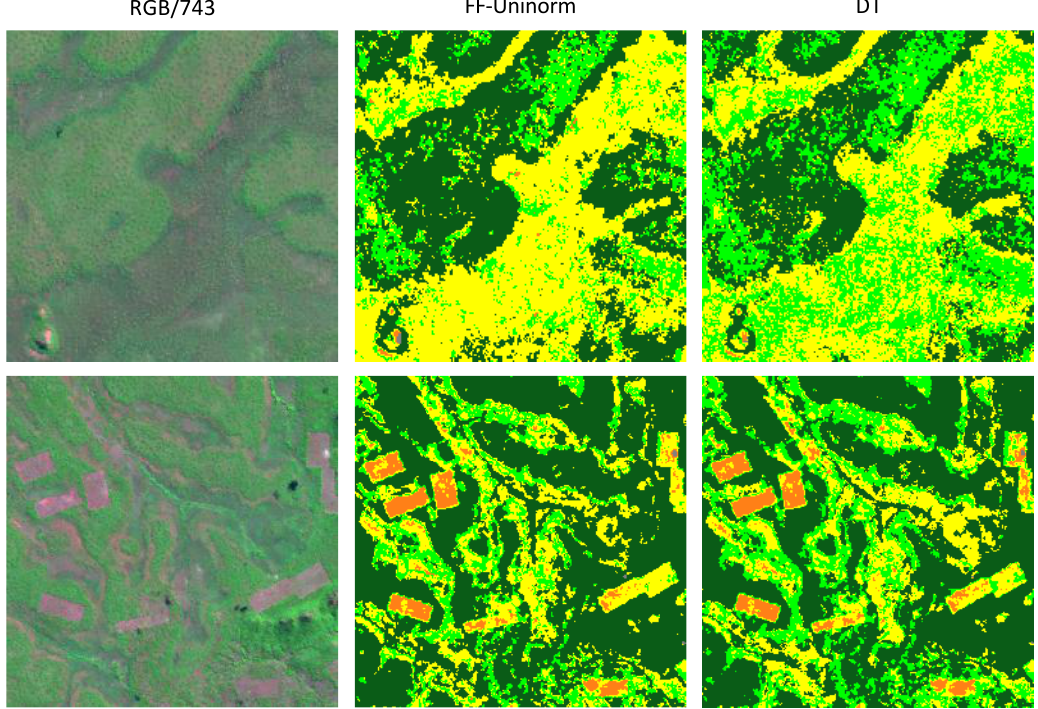
Figure 7. ( Top row ) Detail on the Grassland and Shrubland classification comparison between FF-Uninorm and DT. ( Bottom row ) Correct and detailed classification obtained by FF-Uninorm and DT.